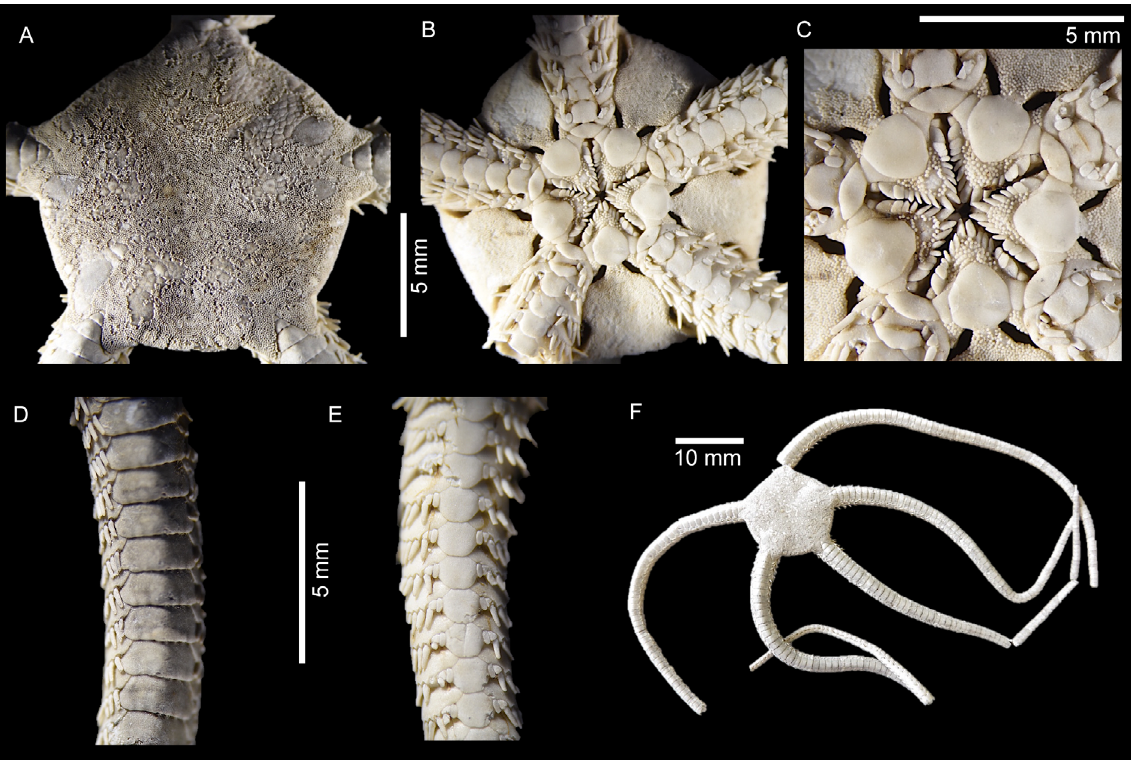
Fig. 8. Ophioderma variegatum Lütken, 1856, lectotype (NHMD-107680, DD = 12.4 mm). A . Dorsal disc. B . Ventral disc. C . Mouth. D . Dorsal arm. E . Ventral arm. F . Dorsal